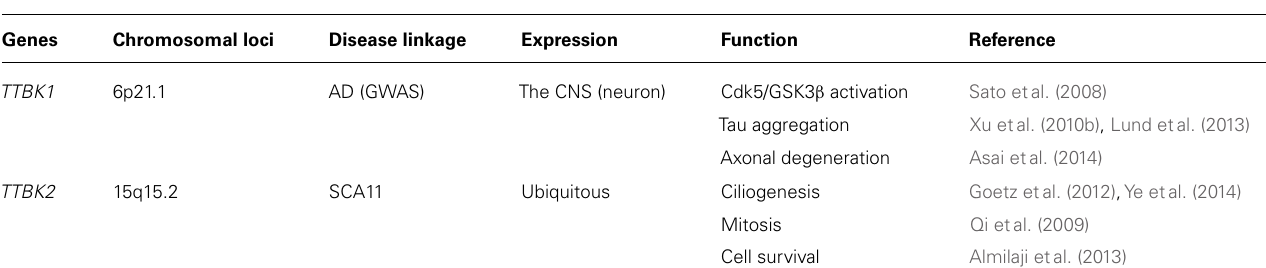
Table 1 | Summary ofTTBK family. Genes Chromosomal